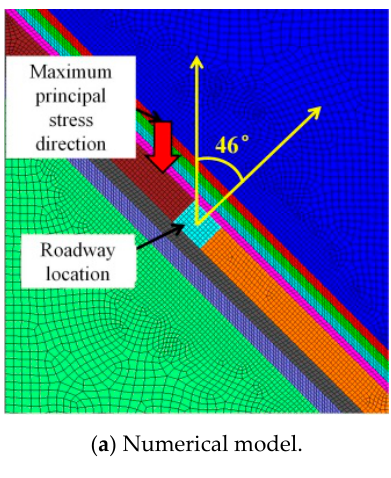
Table 1. Rock mechanics parameters of the coal seam roof and floor.